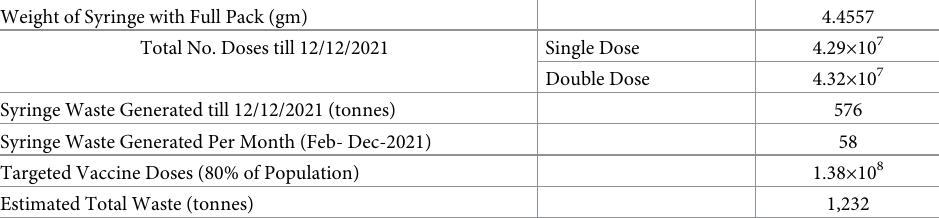
Table 6. Waste estimation of syringes and sharps (full packet). [Data Source: